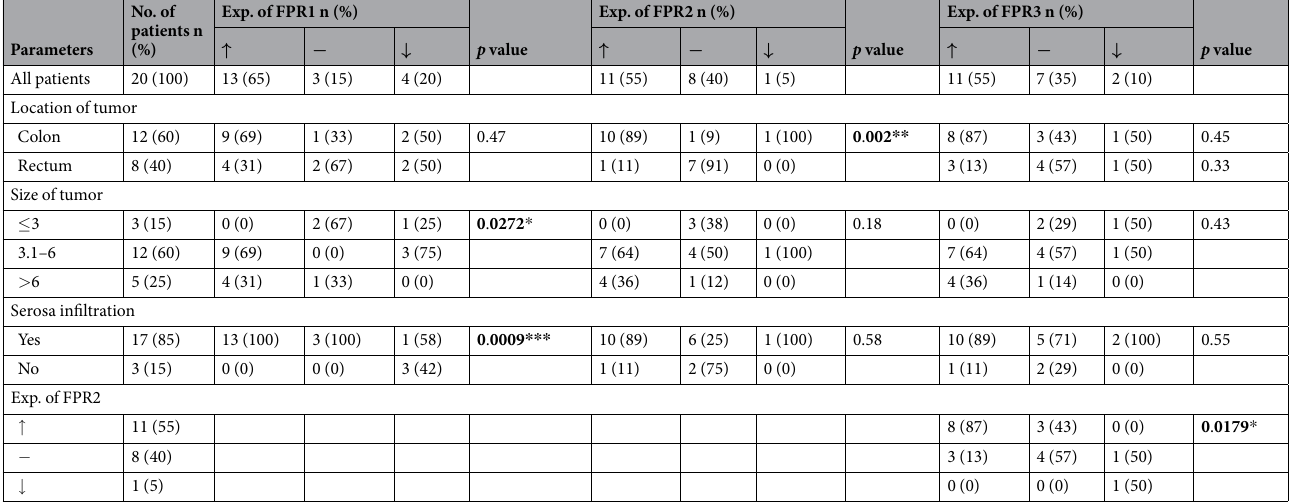
tumor ( p < 0.05). The expression level of FPR3 was not significantly associated with any of these characteristics, except for the expression of FPR2 ( p < 0.05) (Table 1). These results suggest that the expression level of FPR1, but not that of FPR2 and FPR3, may be functionally related to tumor cell invasion in CRC patients. We further examined the expression of FPR1 at the protein level using western blot with an anti-FPR1 antibody, normalized against the expression level of β -actin. Significant upregulation of FPR1 protein level was found in CRC tissue compared with distant normal tissues and adjacent non-tumor tissues (Fig. 1b and c), which was consistent with its mRNA expression profile. FPR1 expression in colorectal epitheliums and in tumor infiltrating neutrophils/mac-